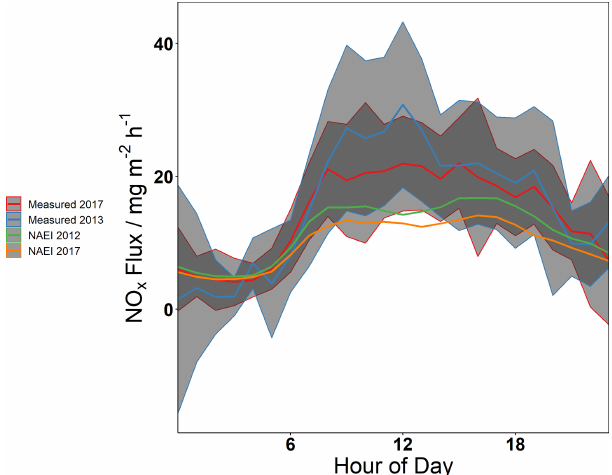
Figure 13. Diurnal profiles of measured NO x flux in 2013 (blue, recalculated from Lee et al., 2015) and 2017 (red, this study) com- pared with inventory time series generated from 2012 (green) and 2017 (orange) versions of the